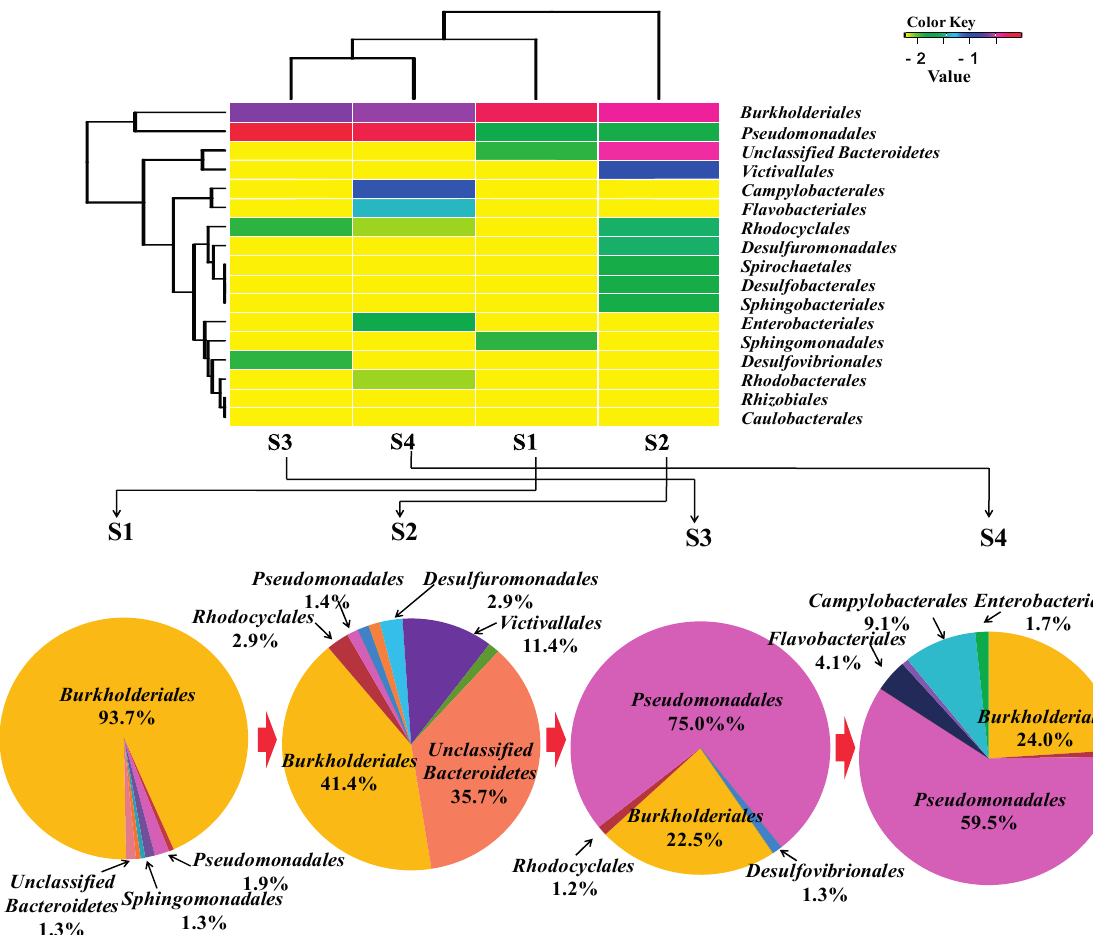
Figure 3. Relative abundance of bacterial orders detected in samples of an oilfield